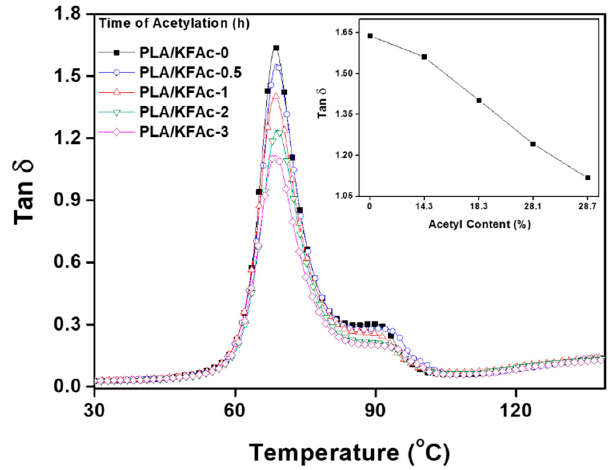
Figure 9. Tan δ of untreated and acetylated kenaf-filled PLA composites.